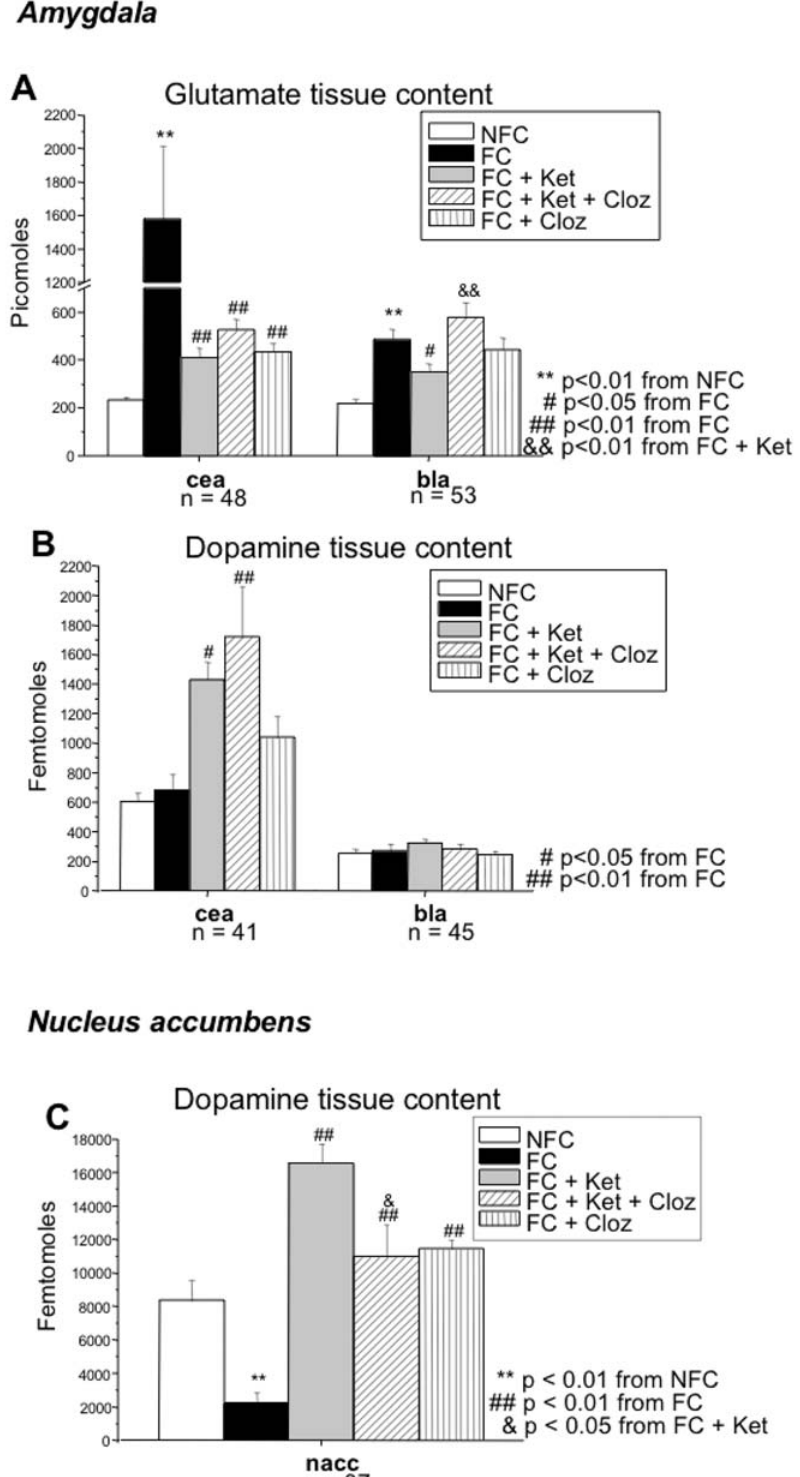
Figure 6. Neurotransmitter content. Bars represent means 6 SEM. The FC group showed increased glutamate levels (A) in the central and basolateral amygdala, as compared to the NFC group. Ketamine also significantly inhibited this effect in both amygdala nuclei, as revealed by the comparison between FC + Ket and FC groups. Clozapine, in turn, blocked the actions of ketamine on glutamate levels (FC + Ket versus FC + Ket + Cloz) in the central amygdala nucleus, with full restoration of normalfear conditioned-induced glutamate levels in the basolateral amygdala. Clozapine alone (FC + Cloz vs. FC) decreased glutamate levels in the central amygdala. In terms of dopamine content, there were no differences between the FC and NFC groups in either amygdala nuclei (B). A decrease in dopamine content was, however, noted in the nucleus accumbens (C). Ketamine abolished this fear conditioning response, and clozapine partially counteracted the effect of ketamine in the nucleus accumbens. Clozapine alone (no ketamine) also showed effects (FC + Cloz), and increased dopamine content in the nucleus accumbens as compared to the FC group. Ketamine in combination with clozapine (FC + Ket + Cloz; or alone (FC + Ket) increased dopamine levels in the central amygdala (B) as compared to the FC only group. Bla, basolateral amygdala nucleus; cea, central amygdala nucleus; Cloz, clozapine; FC, fear conditioning; Ket, ketamine; nacc, nucleus accumbens; NFC, no fear conditioning. doi:10.1371/journal.pone.0001360.g006 PLoS ONE |